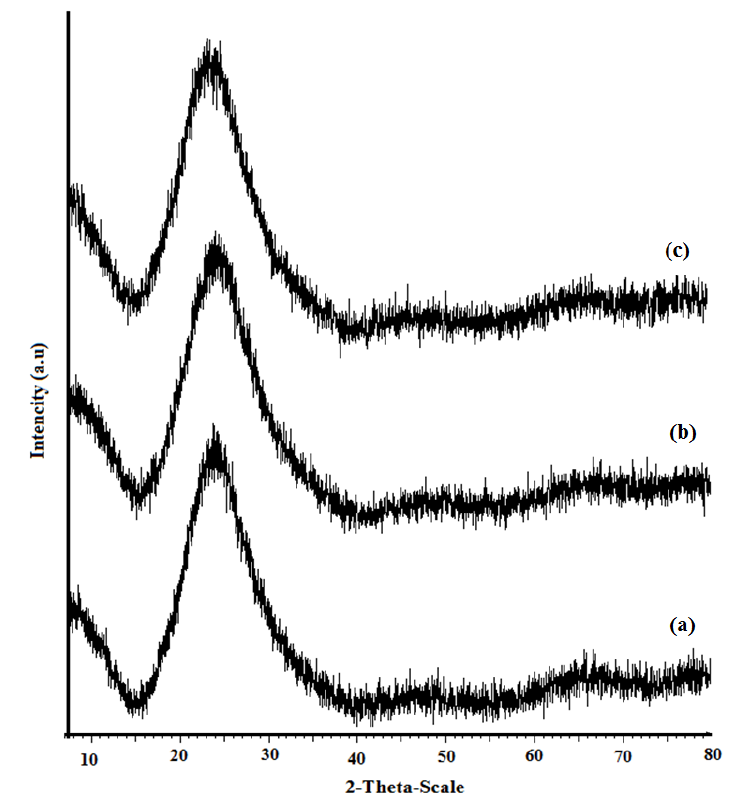
Figure 6. The XRD spectra for ( a ) SiO ( c ) SiO NPs-NH 2 2